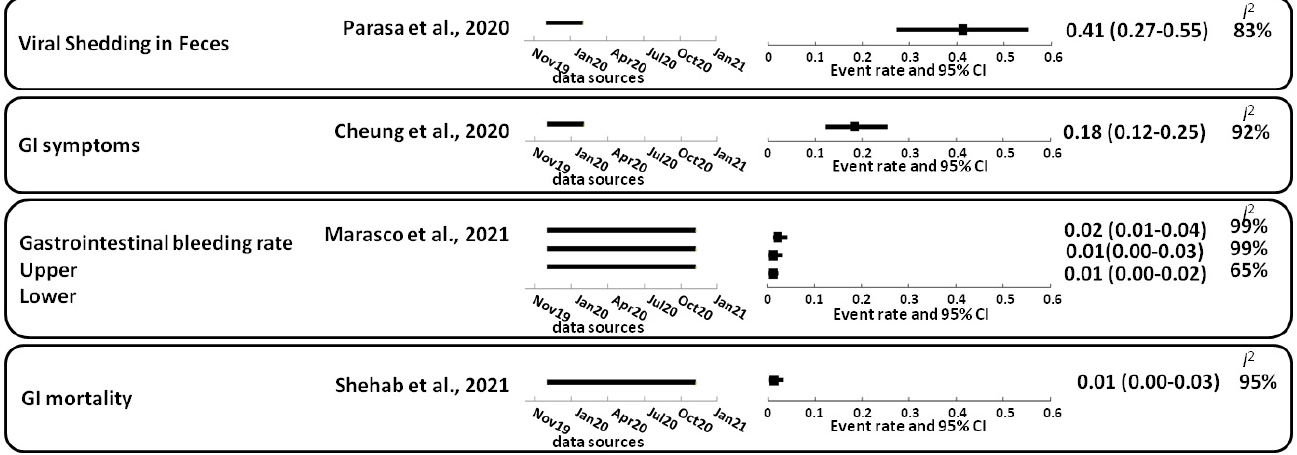
Figure 1. Gastrointestinal symptoms, bleeding, and mortality in patients with COVID-19. The 95% confidence interval (95% CI); random-effects model estimate. For the I 2 statistic, the level of heterogeneity was defined as low (25–50%), moderate (50–75%), or high (>75%). Squares indicate proportions. GI, gastrointestinal. References: Cheung et al., 2020 [9]; Marasco et al., 2021 [11]; Parasa et al., 2020 [7]; Shehab et al., 2021 [12].